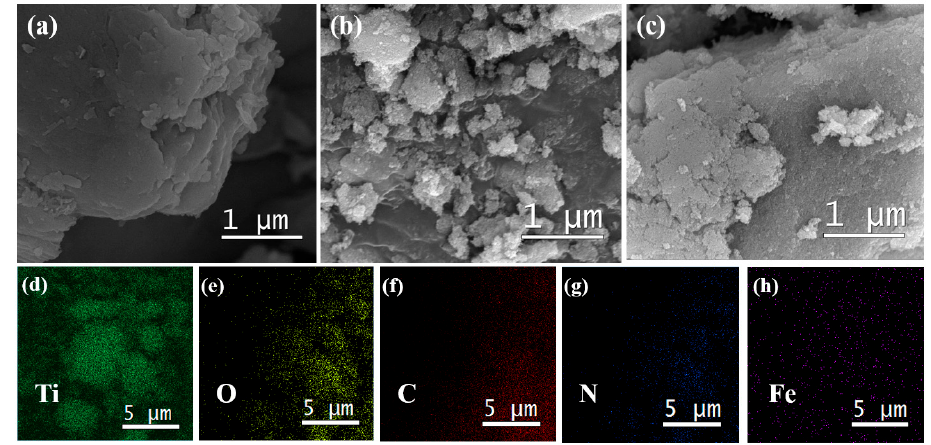
Figure 2. SEM images ( a ) g ‐ C 3 N 4 ; ( b ) Fe ‐ TiO 2 ; ( c ) 0.05Fe ‐ CT; ( d – h ) EDX mapping of 0.05Fe ‐ CT .